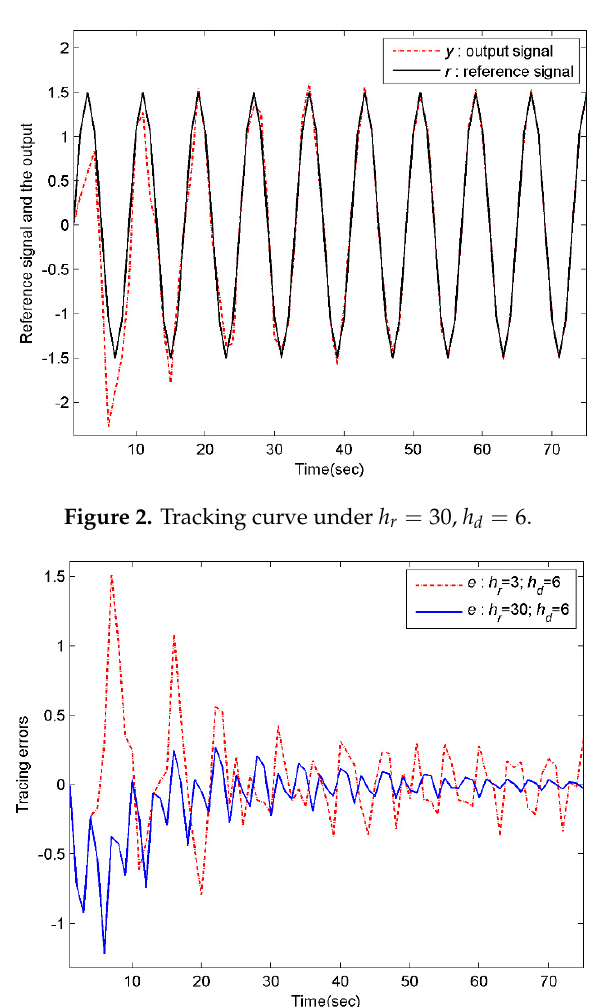
3 h = 6 h = r d , . 3 h = 6 h = r d , .